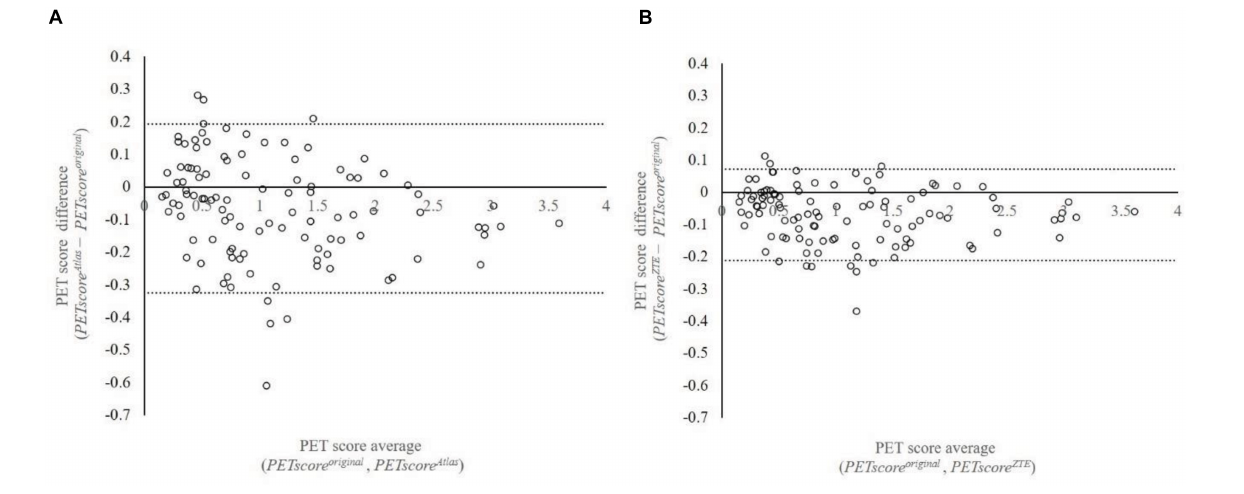
FIGURE 2 | Bland-Altman plot between PETscore MRAC and PETscore original . This plot shows 107 data which are averaged based on 27 error maps. The vertical axis shows difference of PETscore original and PETscore Atlas (A) or PETscore ZTE (B) . The horizontal axis shows average of PETscore original and PETscore Atlas (A) or PETscore ZTE (B) . LOA were –0.323 to 0.194 (A) and –0.211 to 0.073 (B) , respectively. LOA, limits of agreement.